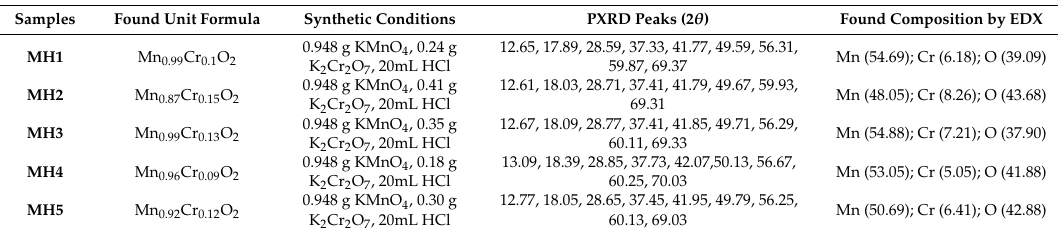
Table 1. Synthetic conditions, powder X-ray di ff raction (PXRD) peaks and found composition (energy dispersive X-ray; EDX) of synthesized nanomaterials (MH1–MH5). Samples